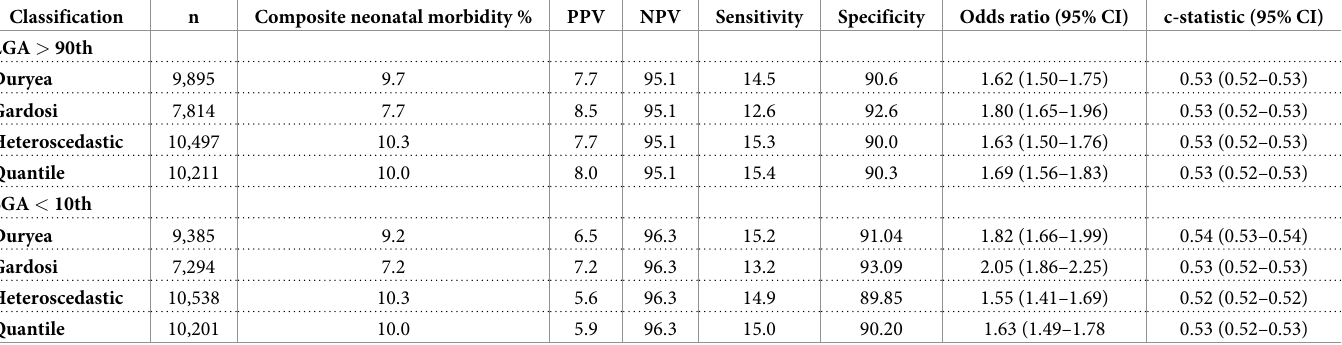
Table 4. Comparison of model performance for the three different methods in detecting SGA and LGA with morbidity for birthweight at 37–42 weeks of gestation in the Consortium on Safe Labor study (N = 102,012).